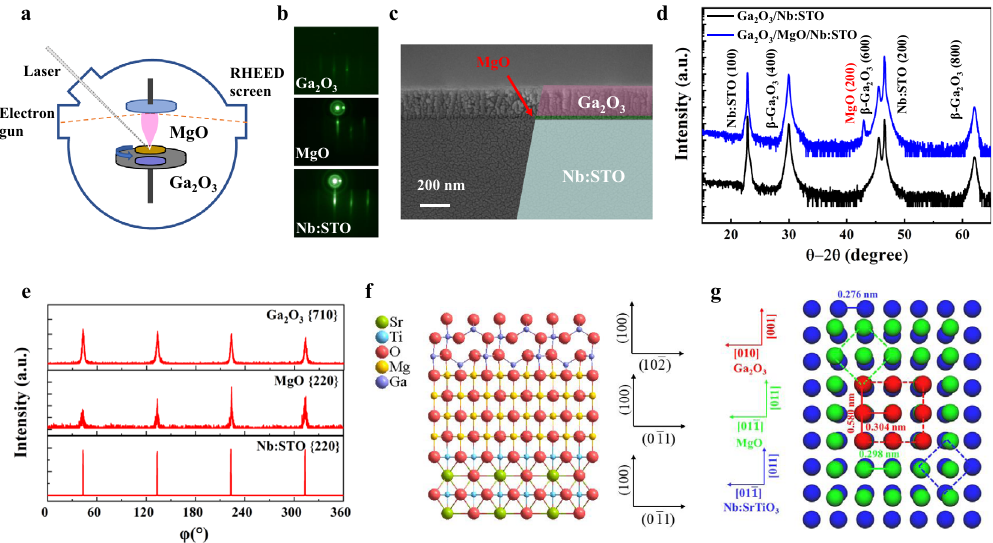
c Cross-sectional SEM image. d XRD θ − 2 θ scan. e XRD Φ -scan. f Schematic atomic arrangement of the cross-sectional heterostructure. g Schematic interfacial oxygen-atom